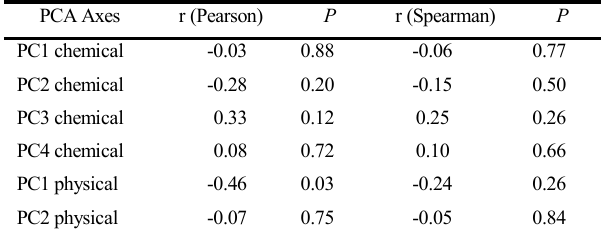
Table 4. Pearson and Spearman correlations (r) between the abundance of Serrapinnus notomelas [transformed in Log (x+1)] and axes retained for interpretation of the principal com- ponents analysis (PCA) applied for chemical and physical variables. P is the probability of finding a larger